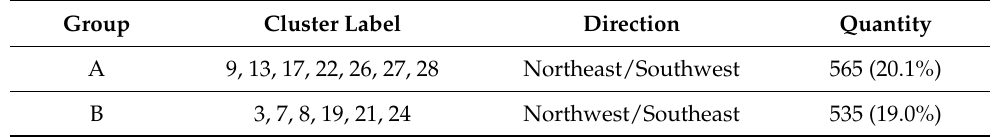
Table 2. Classification of ship’s trajectory